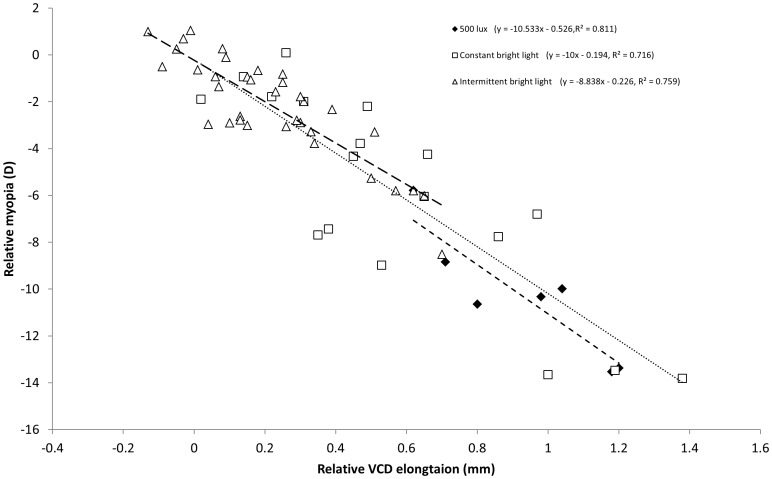
Correlation between vitreous chamber depth and the amount of myopia in chickens under different light regimens.Equations for the linear regression, and R2 values are provided for each light regimen. Long dash line represents the data for intermittent bright light, dotted line for constant bright light and short dash line for standard illuminance, respectively. Note that one diopter of myopia was equivalent to about 0.1 mm of axial elongation across groups (data from one single animal were excluded from the plot because of apparent measurement error, data: −13.9D vs 0.25 mm).